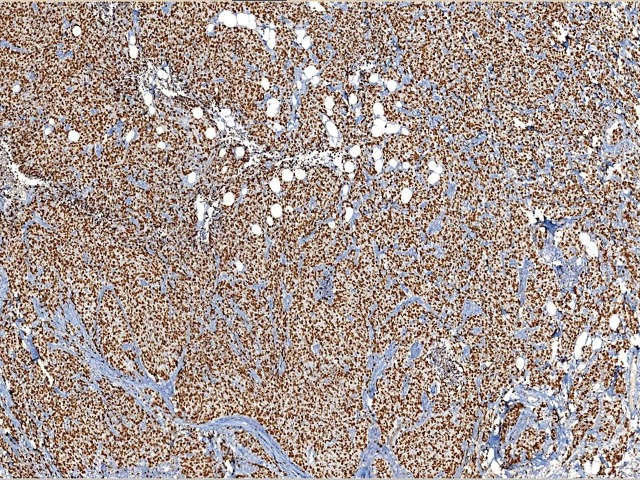
A homogenously stained case of Ki67.High Ki67 LI was diffuse and homogenous across the slide.